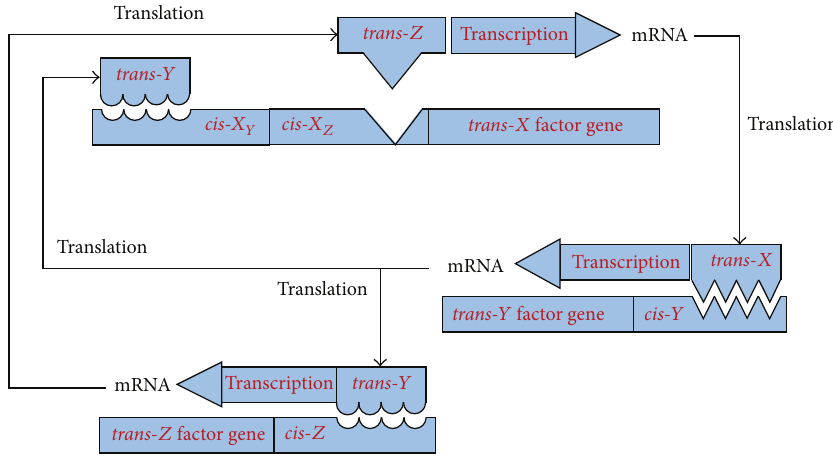
Figure 1: Gene regulation with both positive and negative